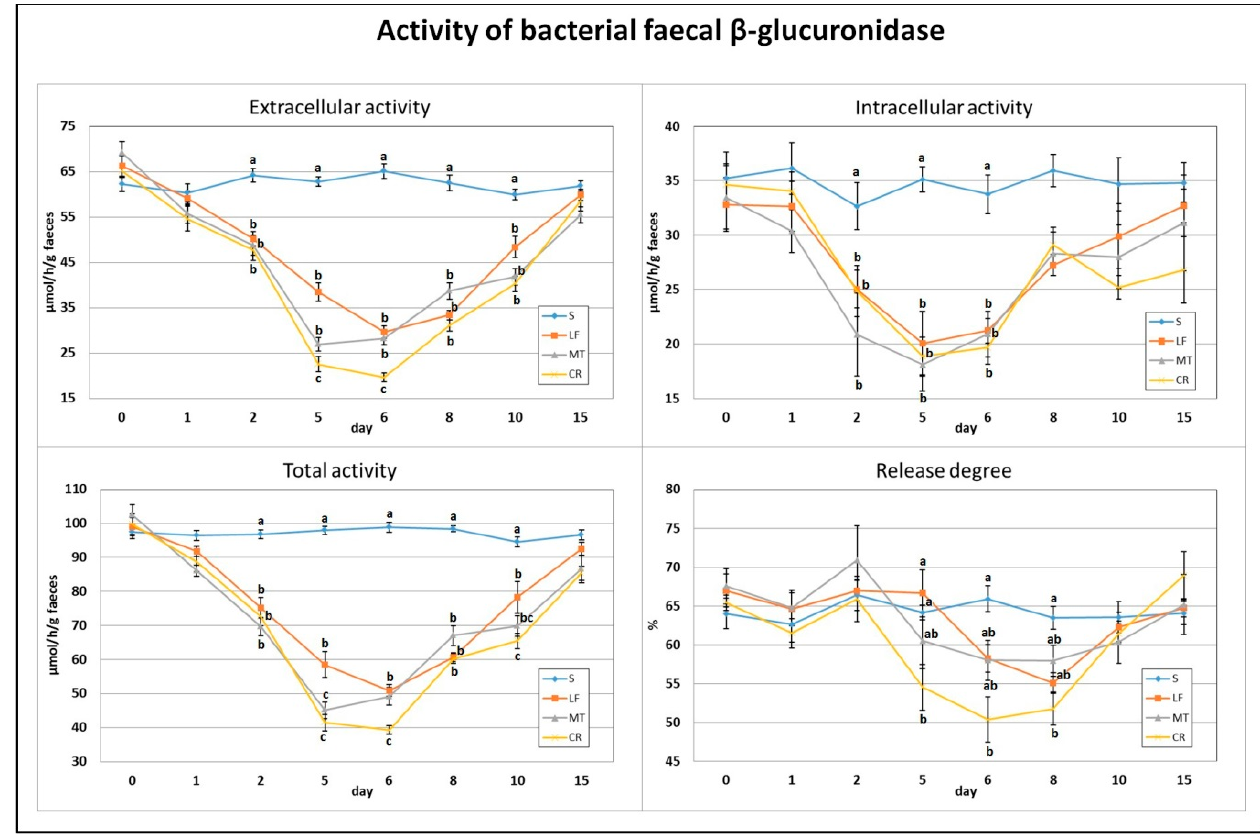
Figure 2. Experimental factor in particular groups: S—control standard diet (0–15 days); LF—standard diet with lactoferrin addition 100 mg/kg (0–5 days diet LF and 6–15 days diet S); MT—standard diet with melittin addition 100 mg/kg (0–5 days diet MT and 6–15 days diet S); CR—standard diet with cecropin A addition 100 mg/kg (0–5 days diet CR and 6–15 days diet S). a,b,c Mean values on the day with no common superscript are different at p ≤ 0.05. Data are presented as the mean with SEM; SEM—SD for all rats divided by the square root of rat number in one group ( n = 8). Release degree, extracellular expressed as percent of total activity.